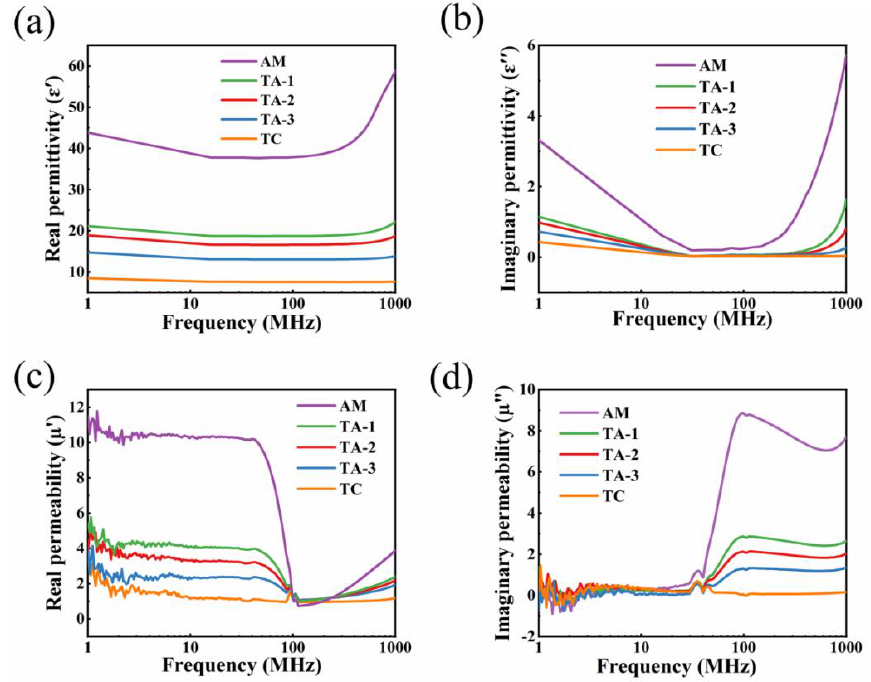
Figure 6. Electromagnetic parameters of composite materials: ( a ) real permittivity, ( b ) imaginary permittivity, ( c ) real permeability, ( d ) imaginary permeability.